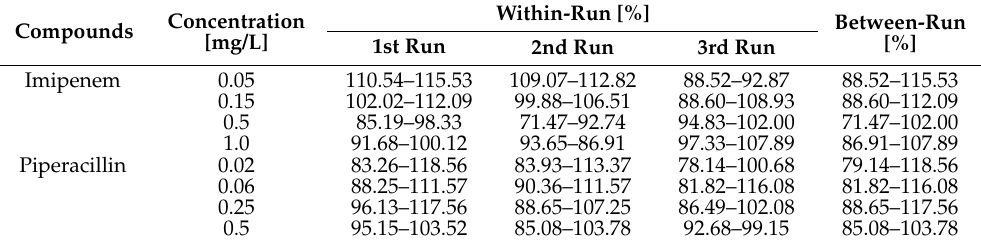
Table 4. Within- and between-run precision presented as the Relative Standard Deviation